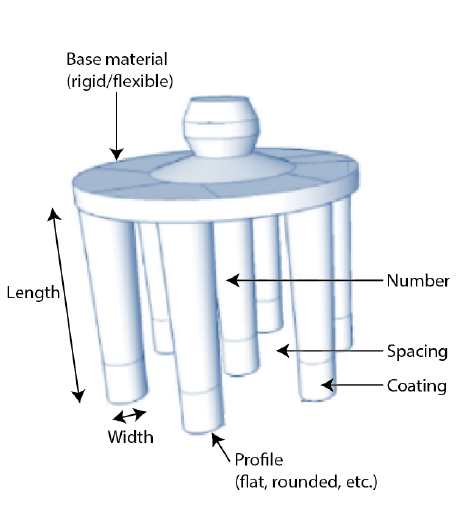
Figure 2. Personalisation parameters in fingered EEG electrodes for making a better connection to the